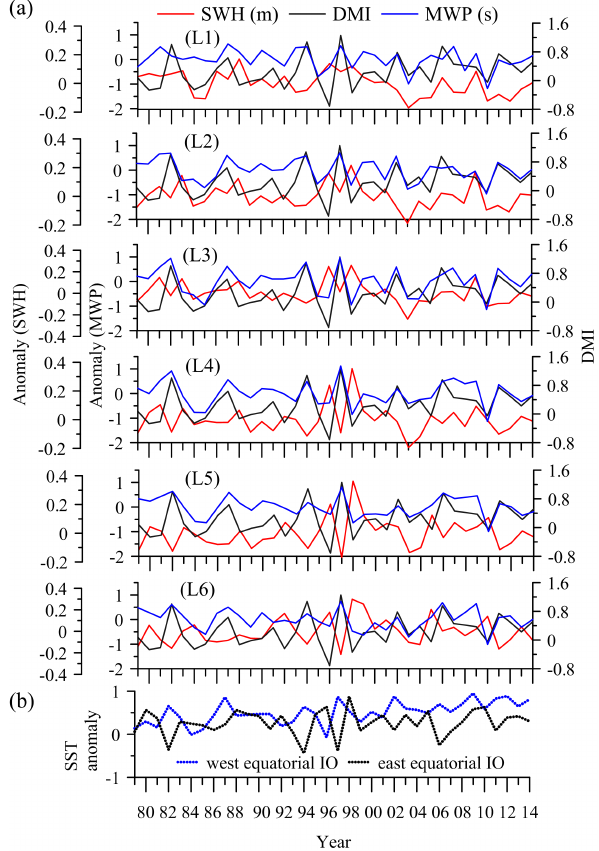
Figure 4. (a) Anomaly of significant wave height (SWH) and mean wave period (MWP) at six selected locations off the west coast of India during October from 1979 to 2014 along with DMI. The wave data are from ERA-I. Locations are shown in Fig. 1. (b) Plot of SST anomaly in the west and east equatorial IO. SST data are from